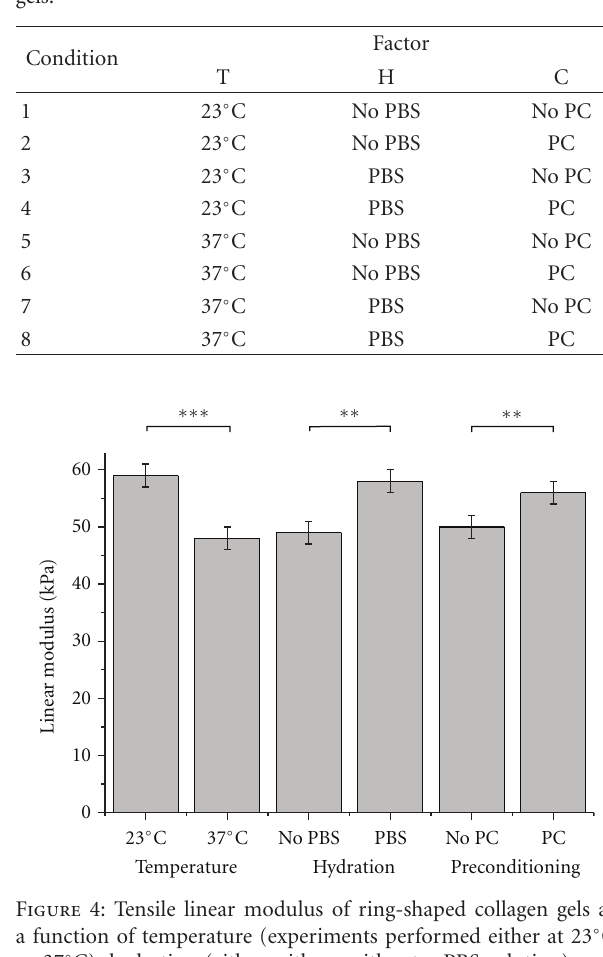
Table 2: Design of the experiments. A complete factorial experi- ment was used to estimate the e ff ects of temperature (T, 23 or 37 ◦ C), hydration (in a phosphate-bu ff ered saline solution: PBS or without: no PBS) and mechanical preconditioning (C, with: PC or without: